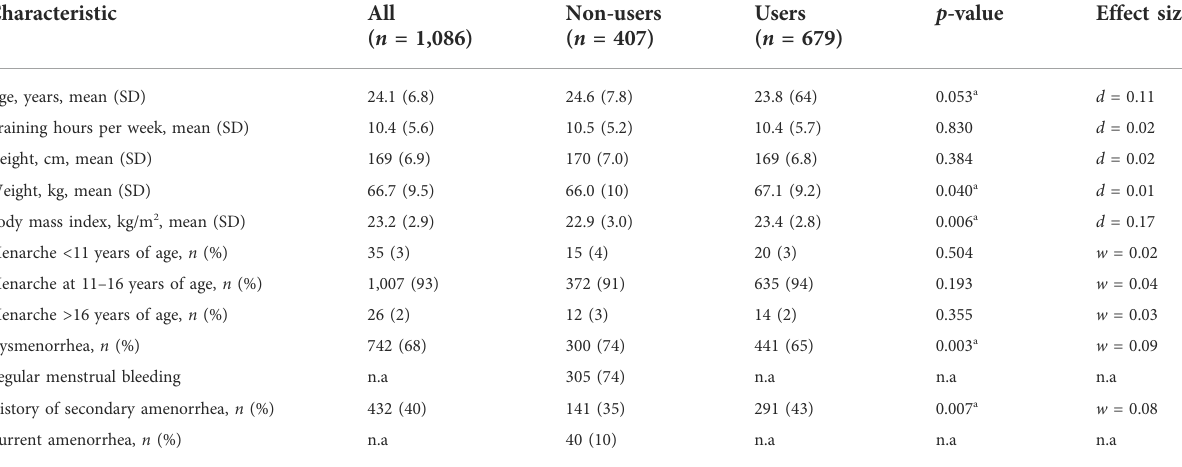
TABLE 2 Demographic characteristics of all respondents and of the sub-groups of non-users and users of hormonal contraceptives (HC). Characteristic